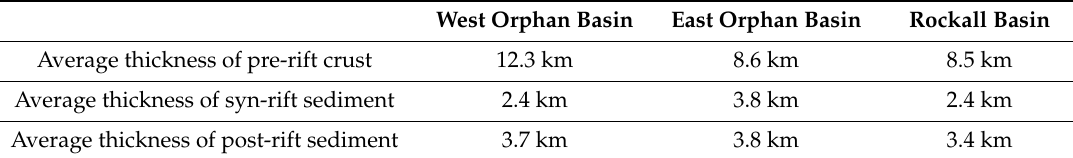
Table 5. Average thicknesses of the pre-rift crust, the syn-rift sediment and the post-rift sediment in the West and East Orphan basins and the Rockall Basin. Values measured from 2D reconstructions generated in MOVE TM . West Orphan Basin East Orphan Basin Rockall Basin Average thickness of pre-rift